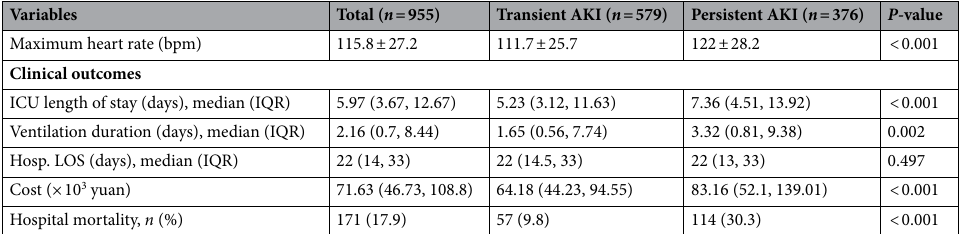
Table 2. Comparisons of baseline characteristics and outcomes between patients with persistent and transient AKI. AKI, acute kidney injury; SOFA, Sepsis-related Organ Failure Assessment; APACHE, Acute Physiology